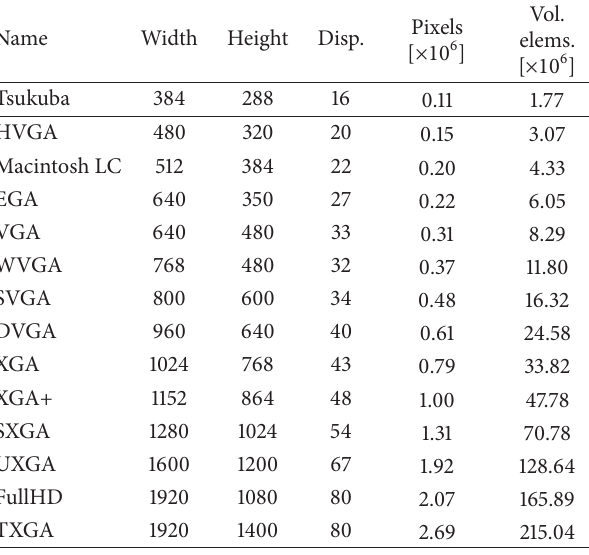
Table 4: Dimensions of low-disparity image series.